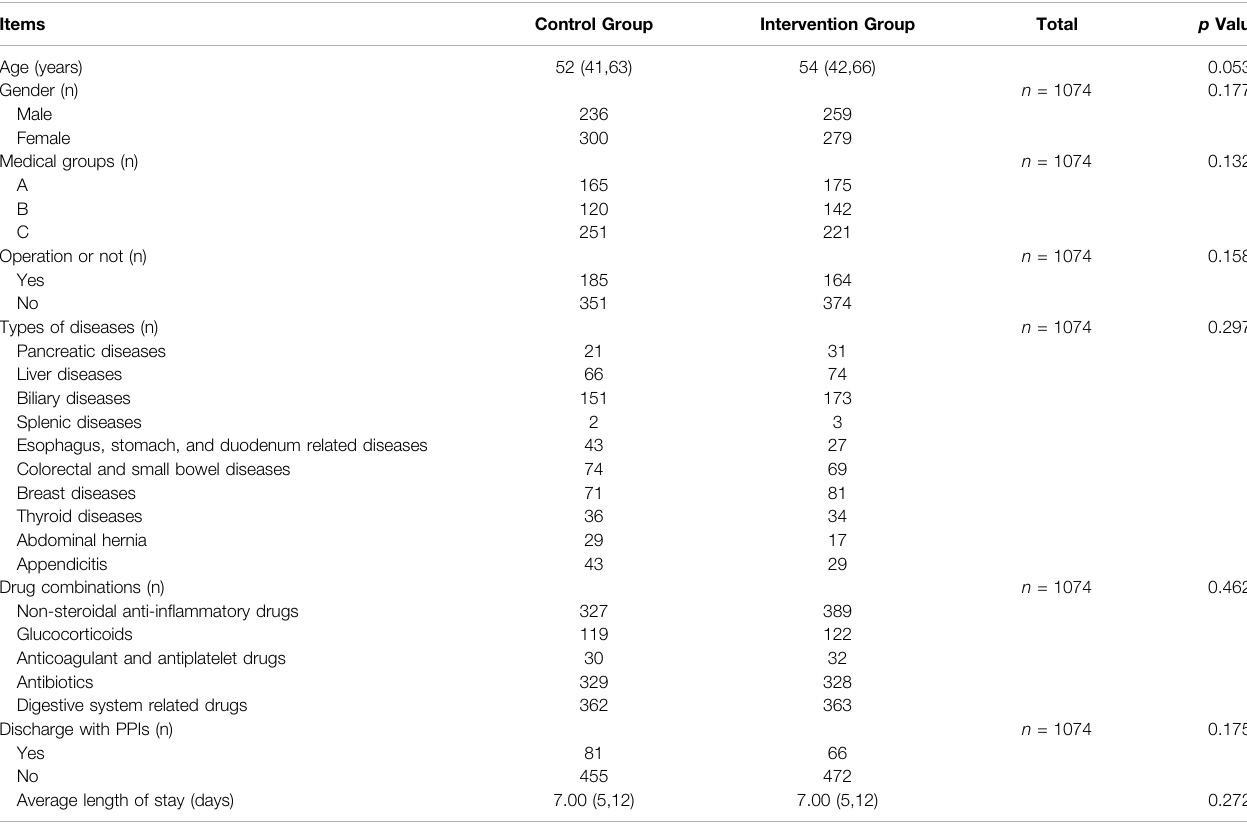
TABLE 2 | Comparison of basic conditions. Items